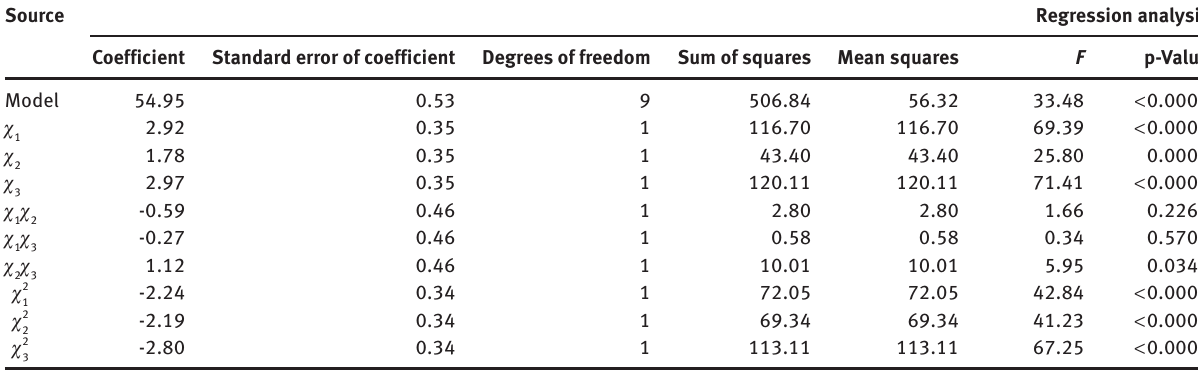
Table 4: Regression coefficients of predicated second-order polynomial model. Source